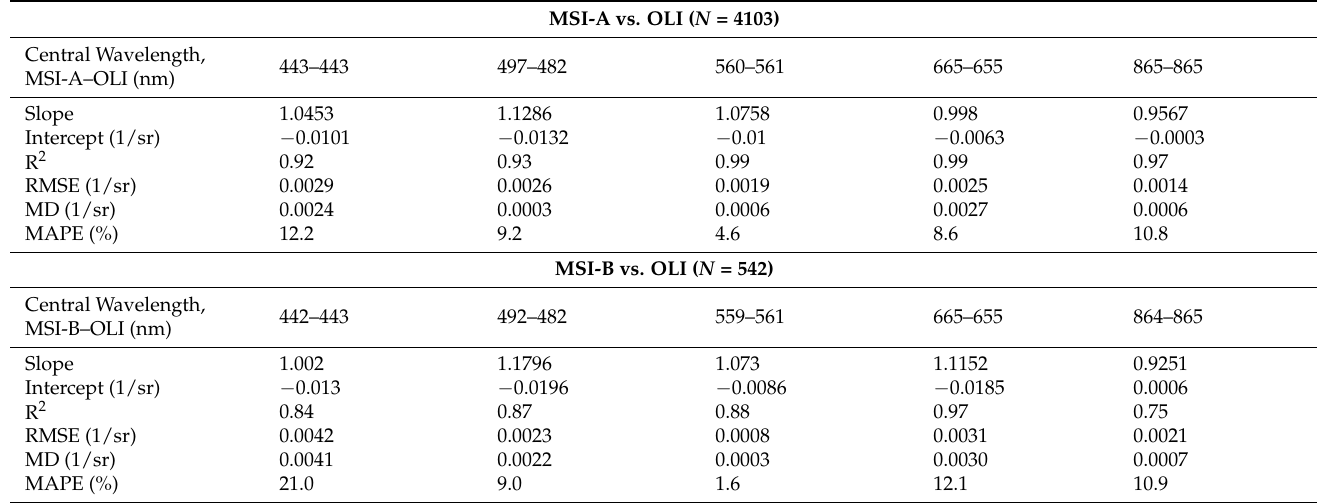
Table 5. Inter-comparison of R rs after vicarious